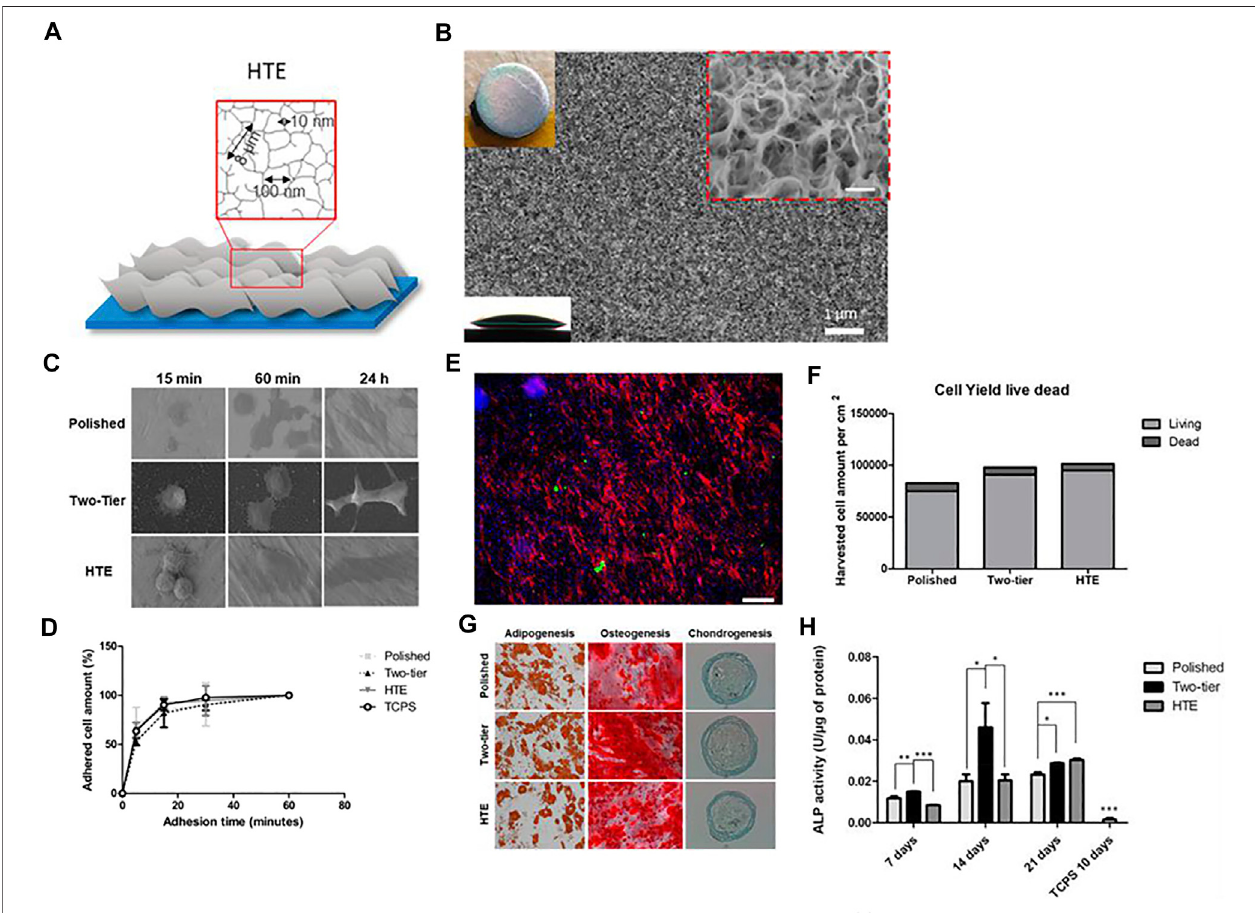
FIGURE 7 | (A,B) Schematic representation and SEM image of hydrothermal treated titanium surface. (C) Different cell morphology on the surfaces over time. (D) Dynamicofcellattachmentondifferenttypesofsurfaces. (E,F) Live/dead cellstainingimagesandcellviabilityafter96 honhydrothermal treatedTisurface.Scalebars= 185 μ m. (G) Staining images showing the differentiation ability of cells on different surfaces. (H) ALP activity of cells in different groups. Reprinted with permission from (Clainche et al., 2020). Copyright 2020, American Chemical